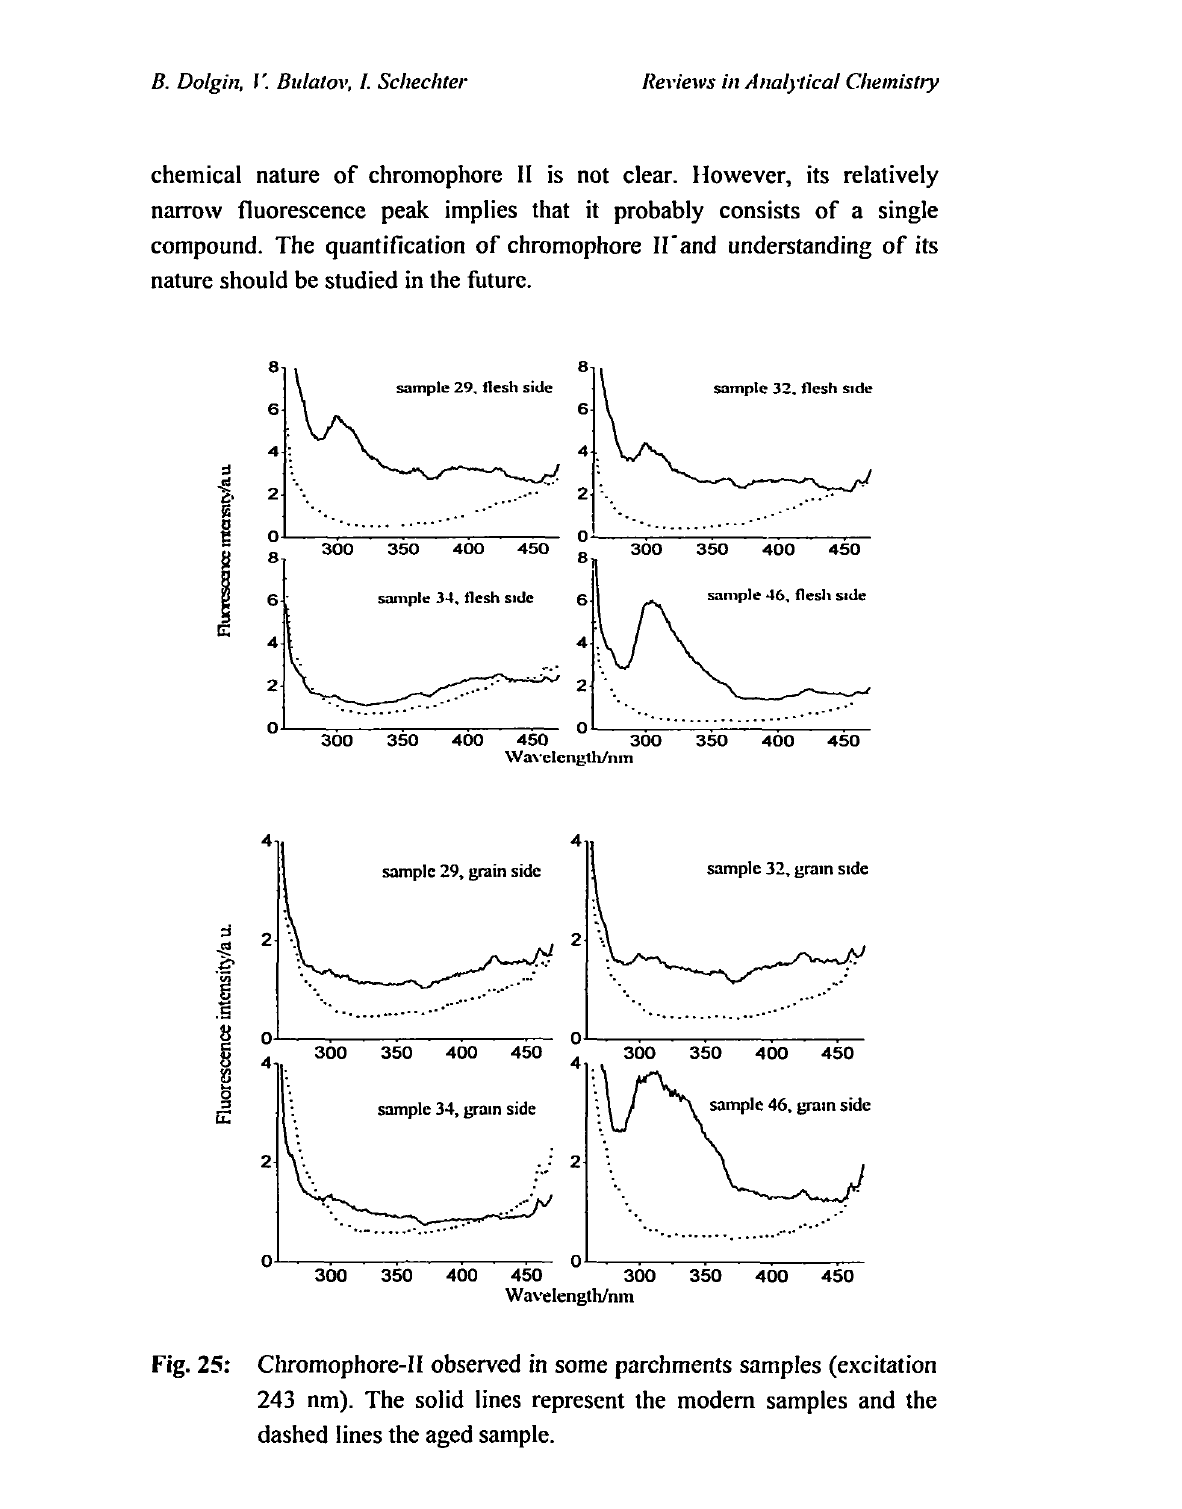
Fig. 25: Chromophore-II observed in some parchments samples (excitation 243 nm). The solid lines represent the modern samples and the dashed lines the aged